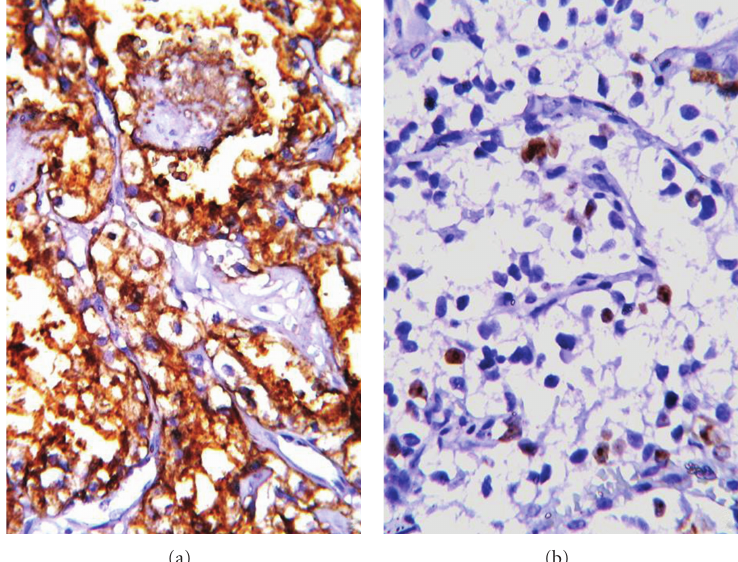
Figure 4: Di ff use positive membranous immunoreaction with antibodies against EMA (a) and focal positive nuclear Ki-67 immunoreaction (b) are observed in the clear cells (ABC-DAB; (a) × 200; (b) ×